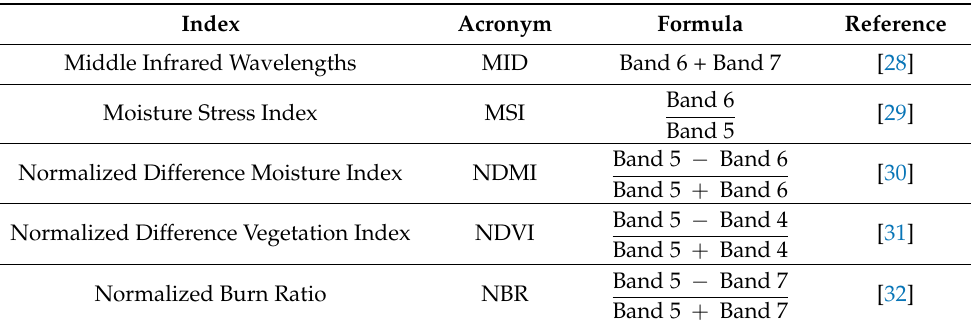
Table 1. Vegetation indices derived from Landsat 8 multispectral